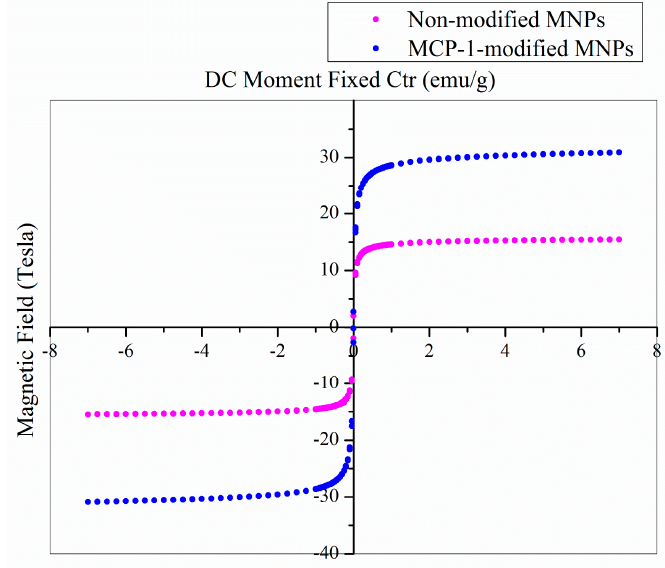
Figure 4. M-H curve/hysteresis loop of iron oxide MNPs.